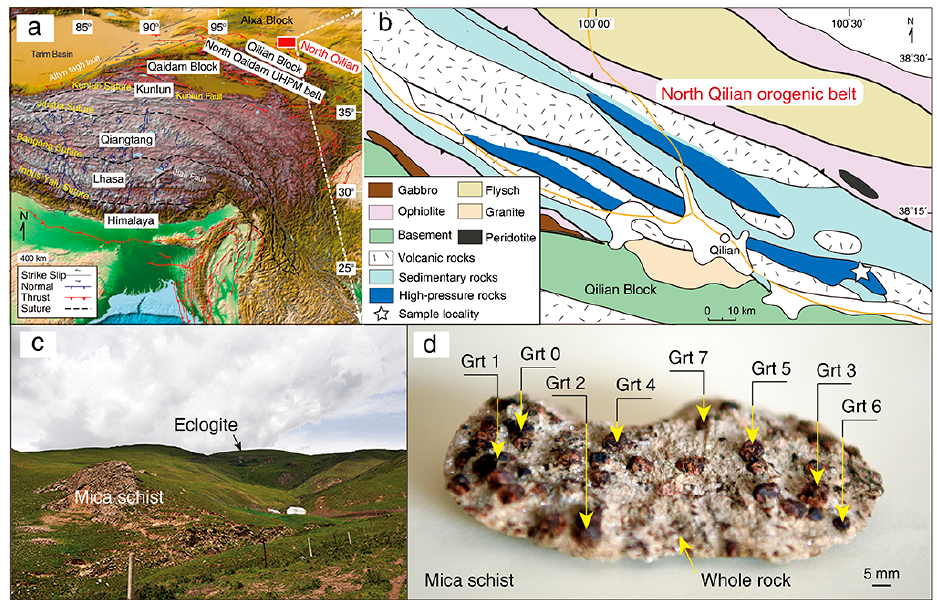
Figure 1. ( a – c ) Tectonic framework and geological map of the study area (after Cheng et al., 2018 [5]), showing the field occurrence of the sample in the North Qilian mica at the Baishiyazi valley. ( d ) A photograph of the highly weathered sample shows the extracted garnet grains for geochronology.